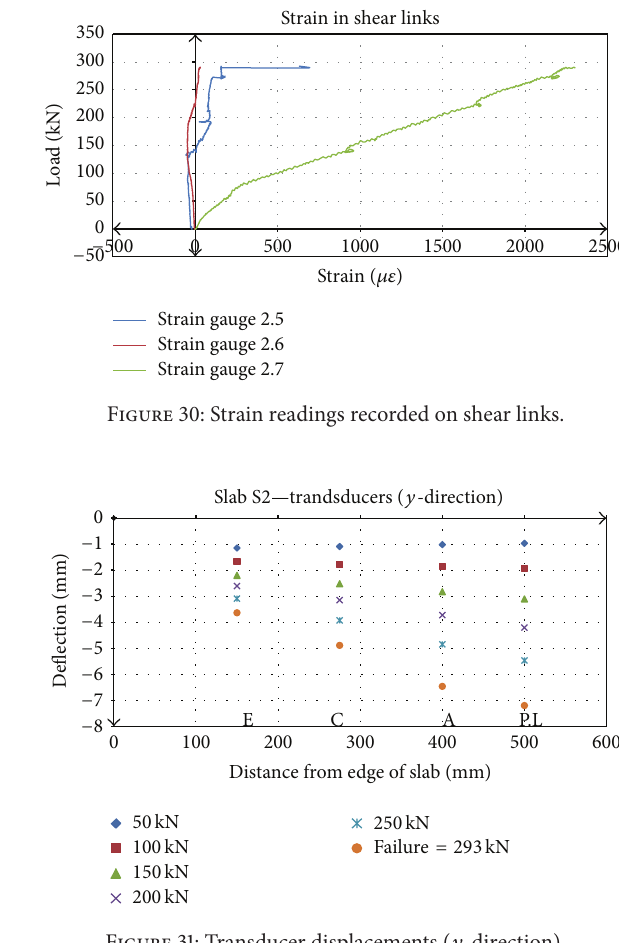
Figure 31: Transducer displacements ( 𝑦